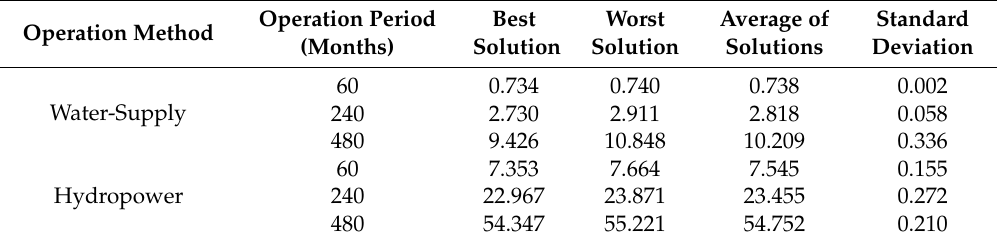
Table 6. Results of “Dez” reservoir operation using CSS algorithm over 10 runs—Considering evaporation